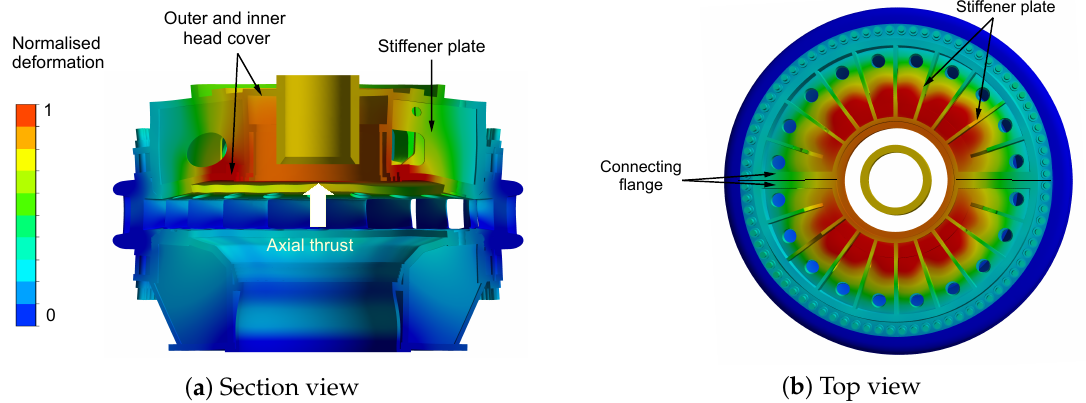
Figure 17. Total deformation distribution of the stationary